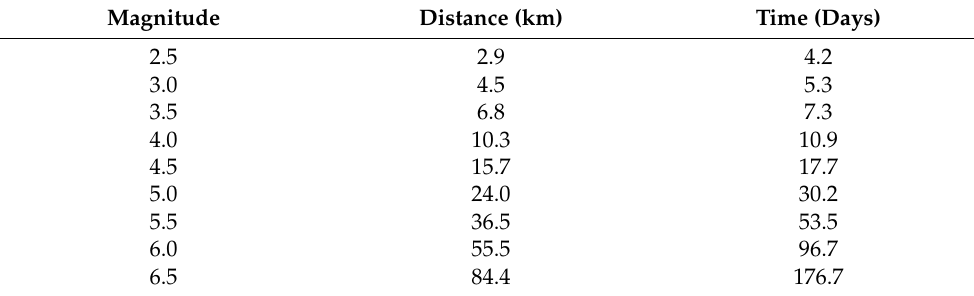
Table 2. Space and time ranges for determining dependent events